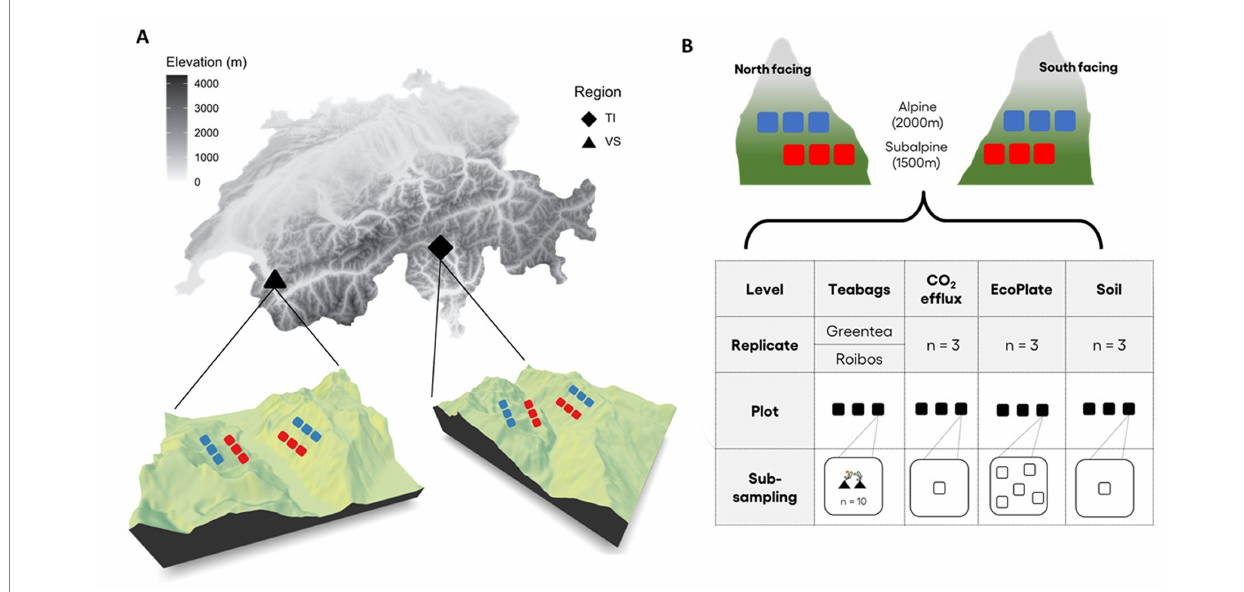
FIGURE 1 Study sites and experimental design. (A) Map of Switzerland showing the location of the two regions where the study took place; Valais ( VS , black triangle) transect in the Northern Alps, and Ticino (TI, black diamond) in the Southern Alps. In both regions, we established a north- and a south-facing altitudinal transect. (B) The elevation transects were divided into two elevation zones; a subalpine zone (1,500 m a.s.l, red squares), and an alpine zone (2,100 m a.s.l., blue squares). On each transect and at each elevation, we defined three replicate plots ( N = 2 regions × 2 expositions × 2 elevation zones × 3 replicates = 24 plots). The graphic shows the different variables sampled in each plot: (i) soil profile description ( n = 1) and soil physicochemical parameters therein, (ii) soil respiration (CO 2 efflux) measures ( n = 3), (iii) carbon degradation bioassay (EcoPlates, n = 5), (iv) tea bags experiment ( n = 10 per plot and per tea type: green tea and rooibos